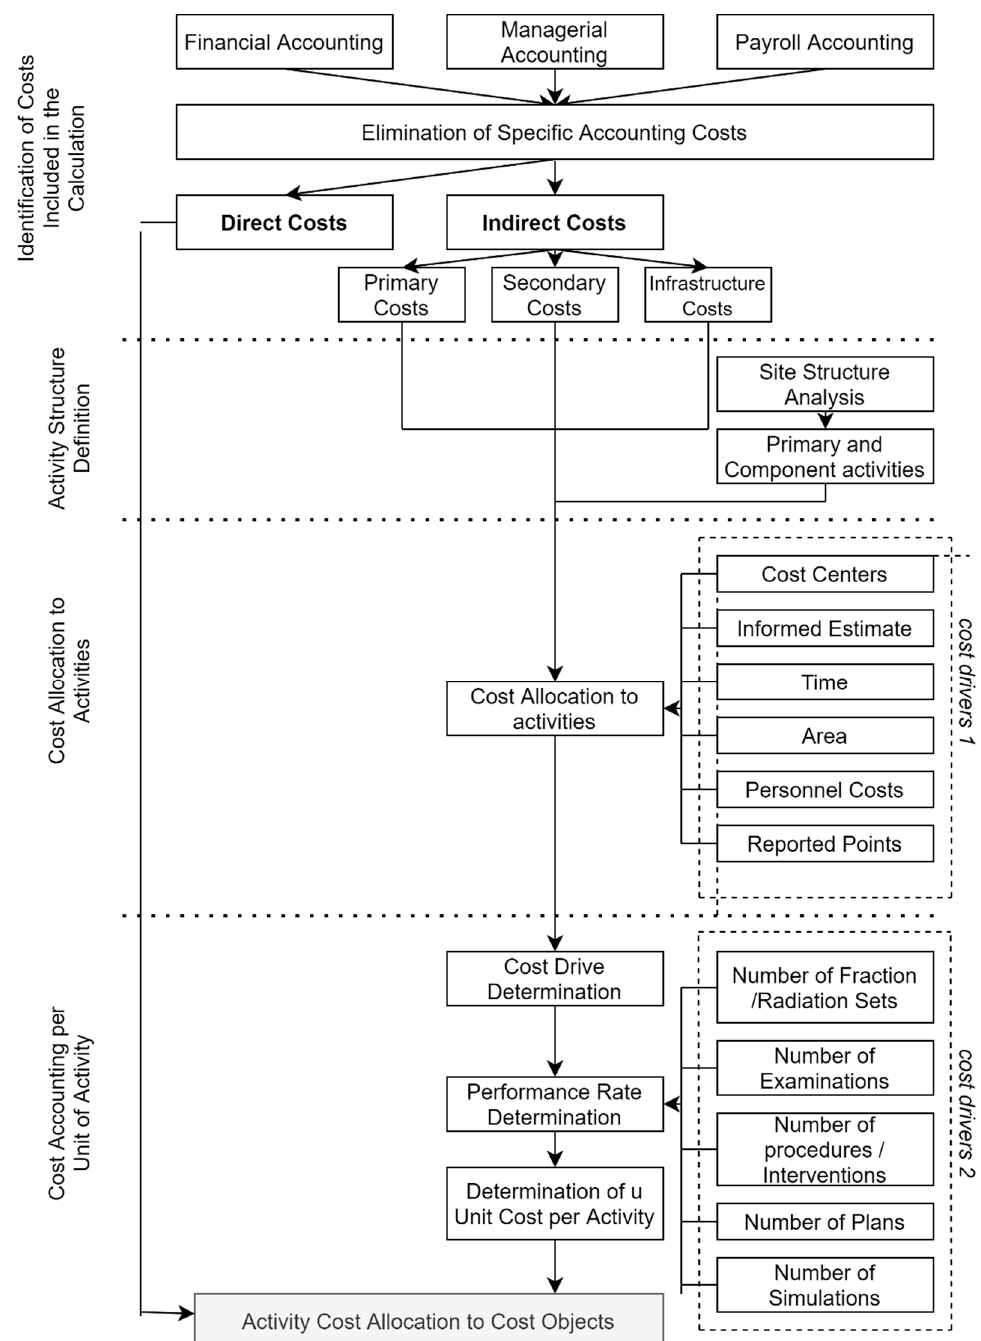
Figure 2. ABC process.